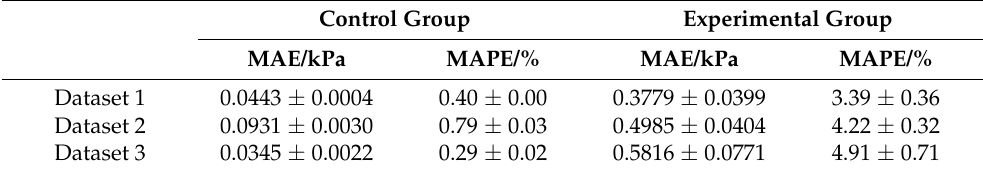
Table 6. The prediction comparison table of differential prediction method.